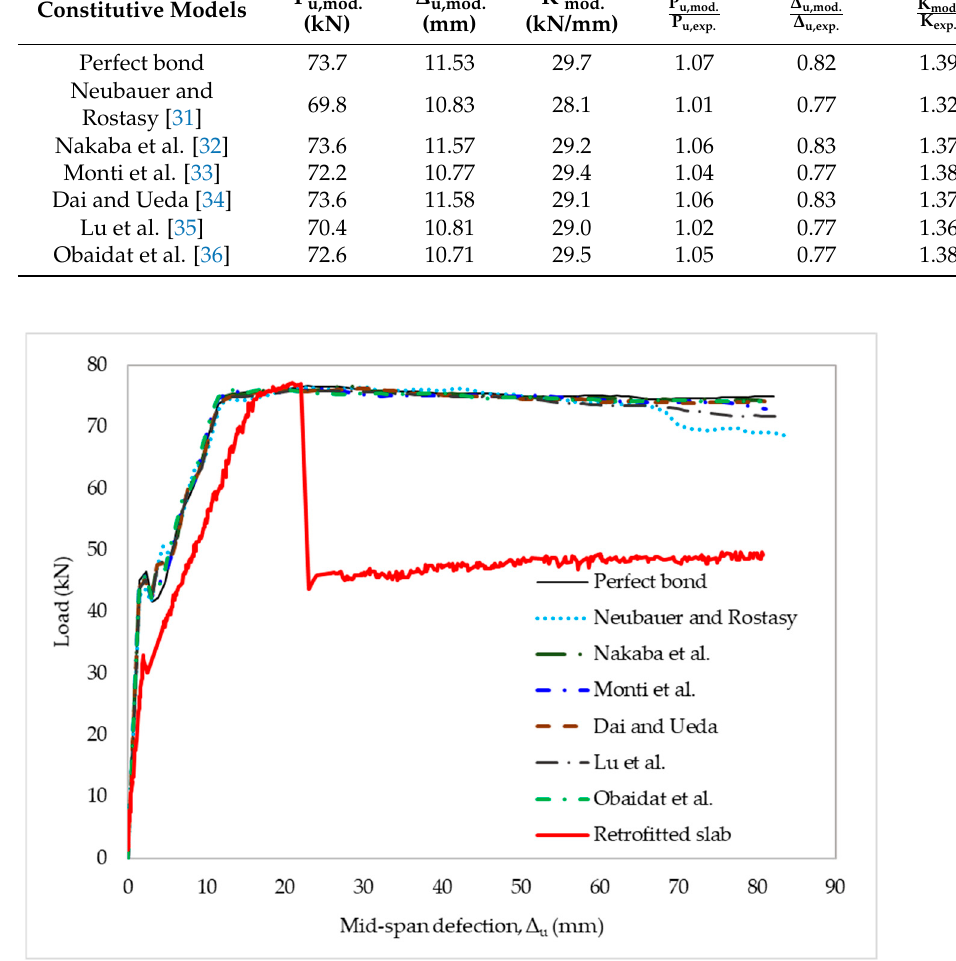
Figure 11. Experimental and FEM models of load–deflection curves for retrofitted slabs.